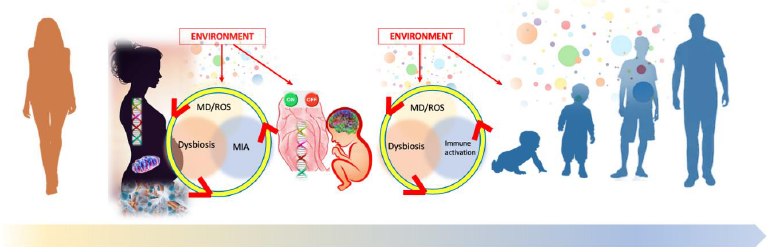
Figure 1. Interplay between the main determinants of Autism Spectrum Disorder. MD, Mitochondrial dysfunction; MIA, Maternal Immune Activation; ROS, Reactive Oxygen Species. In the new individual, matrilinear transfer of mitochondria and microbiota adds to the genetic information stored in the maternal and paternal germinal cells. Environmental factors as a whole may directly affect the epigenetic machinery, as it happens with heavy metals, or may influence the interconnected molecular pathways involved in the ‘bad trio’ (mitochondrial dysfunction (MT)/oxidative stress (ROS) plus maternal immune activation (MIA) plus dysbiosis). The ‘omniscient placenta’ [51] drives the metabolic and epigenetic regulation of fetal programming, hence influencing the ontogenesis and the crucial early stages of neurodevelopment. The epigenome—similarly to a software switching genes on and off [29]—is programmed in an adaptive and predictive sense by the intrauterine and cellular microenvironment, setting the limits of physiological adaptations to the postnatal environment and influencing the lifelong risk for diseases [43]. After birth, the same mechanisms involving environmental factors and the ‘bad trio’ are at play, and may continue to undermine human health lifelong. As for neurodevelopment, the maximum impact occurs in the first two years of life, which is the crucial time window for brain wiring.